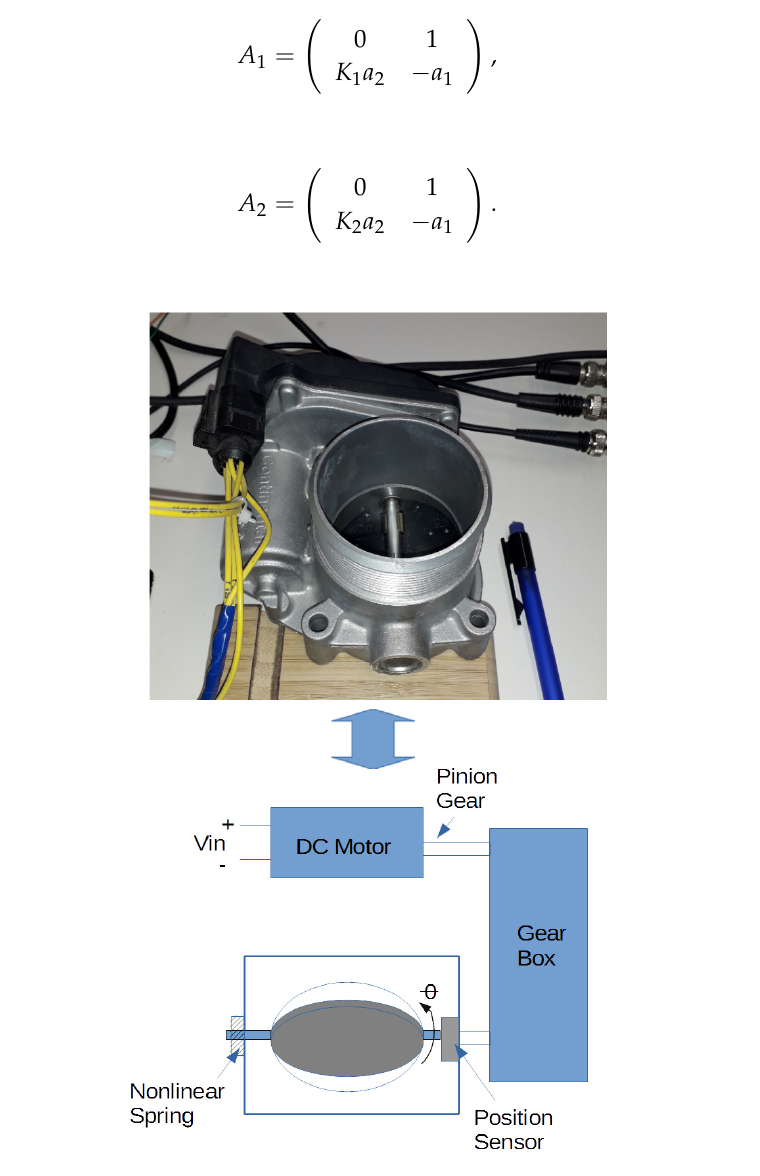
Figure 1. Top: A photo of our throttle device. Bottom: A throttle actuator diagram. V in would be the control signal u ( t )